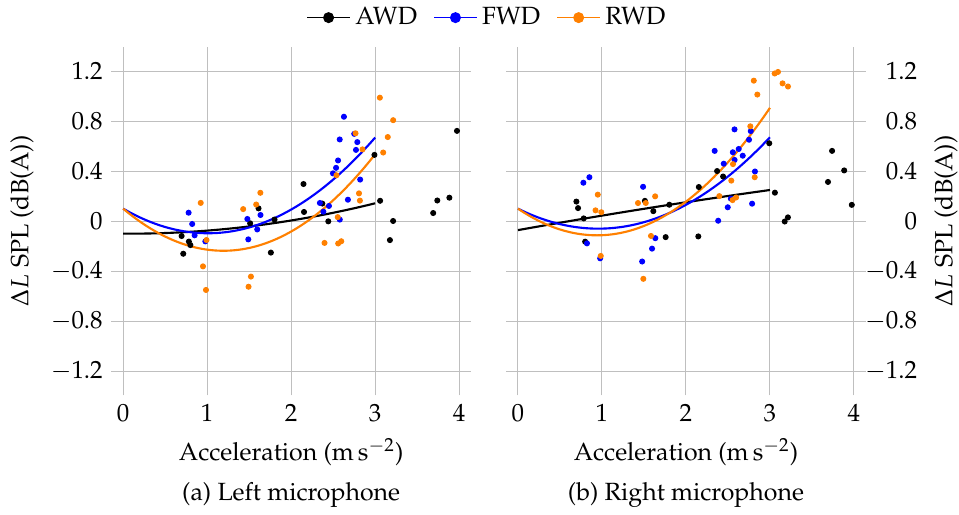
Figure 8. Air temperature corrected additional SPL caused through acceleration for the 255P mounted on the LSBEV for left and right microphone side on Point P-P’ of the measurement